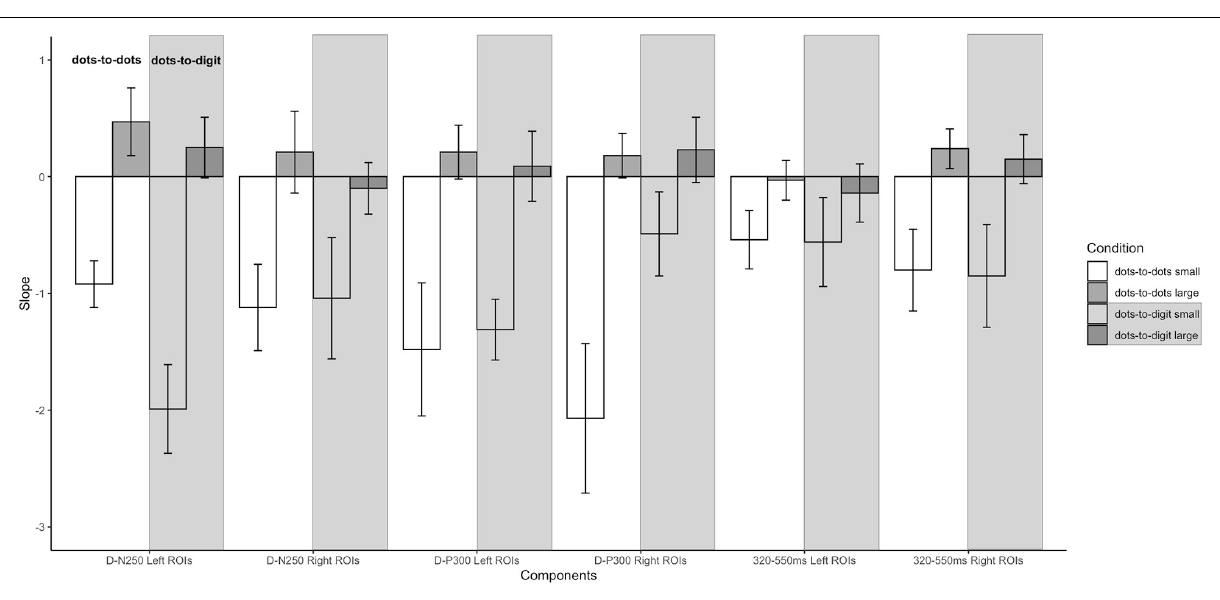
FIGURE 5 | Slopes of pre- and post-inflection segments within each condition for each ERP component. Error bars represent the standard error of the